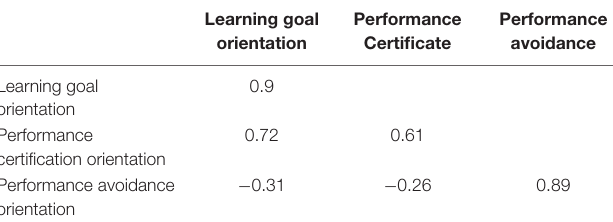
TABLE 4 | Differential